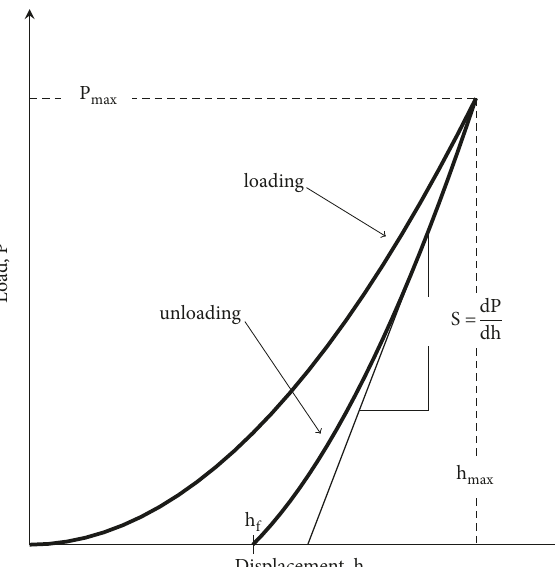
Figure 2: Force-distance curve for graphene oxide. The white line depicts the loading stage, while the black line represents the unloading stage.